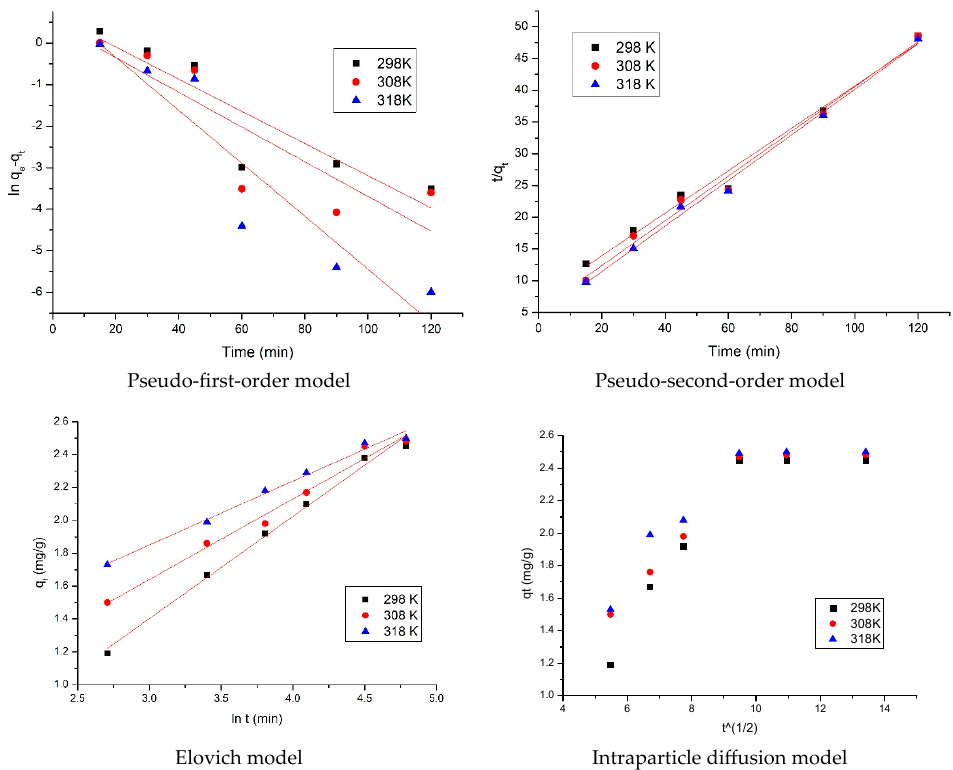
Figure 10. Kinetic, Elovich, and intraparticle diffusion models. Table 3. Kinetic parameters for the adsorption of Au (III) onto BCb/BC.